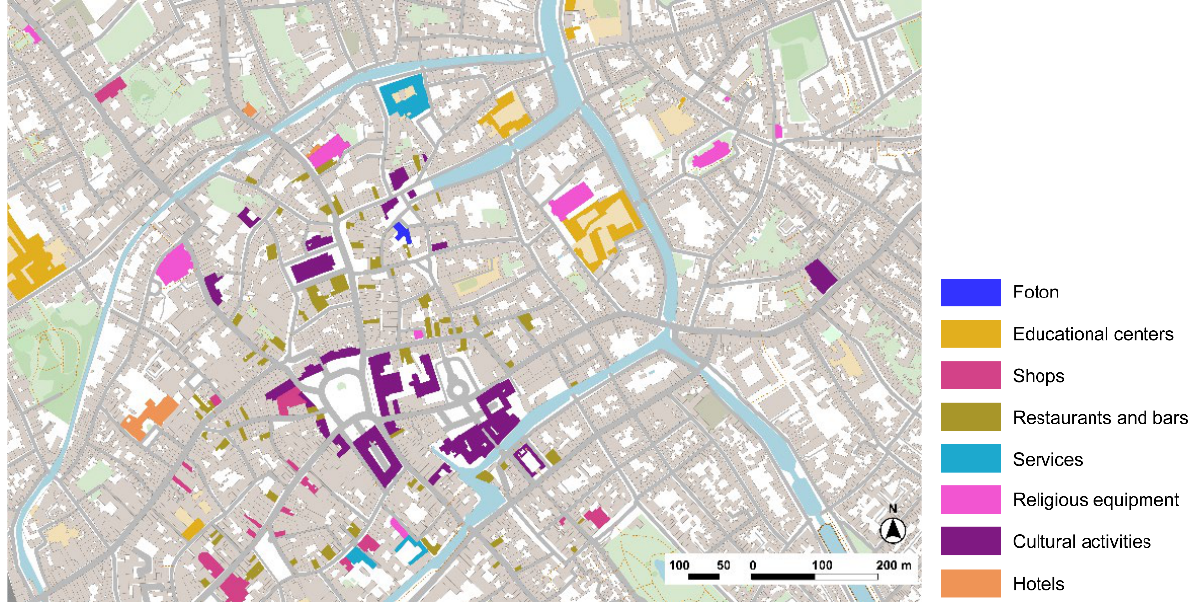
Figure 14. Foton Expertise Center of Dementia and city center of Bruges, Belgium. Source: Own elaboration. Engaging with local shops and pharmacists was one of the long-term projects under a 5-year strategic plan that has been developed in order to raise awareness about dementia, as well as to contribute to reduce the stigma about it. The establishments would put the red knot logo on their showcase and receive specific training to be more confident to interact with people with